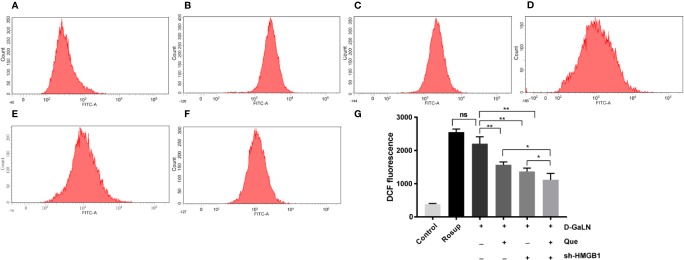
Flow cytometric analysis of the intracellular reactive oxygen species (ROS) levels in L02 cells. (A) Control group; (B) Rosup group; (C) Cells treated with d-GaLN (45 mM) alone; (D) Cells pre-treated with Que (50 μM) and then treated with d-GaLN (45 mM); (E) Cells pre-treated with sh-HMGB1 and then treated with d-GaLN (45 mM); (F) Cells pre-treated with sh-HMGB1 and Que (50 μM) and then treated with d-GaLN (45 mM); (G) Statistical results of ROS. Data are presented as the mean ± SD of three independent experiments (*p < 0.05, **p < 0.01); “ns” indicates not significant (p > 0.05).